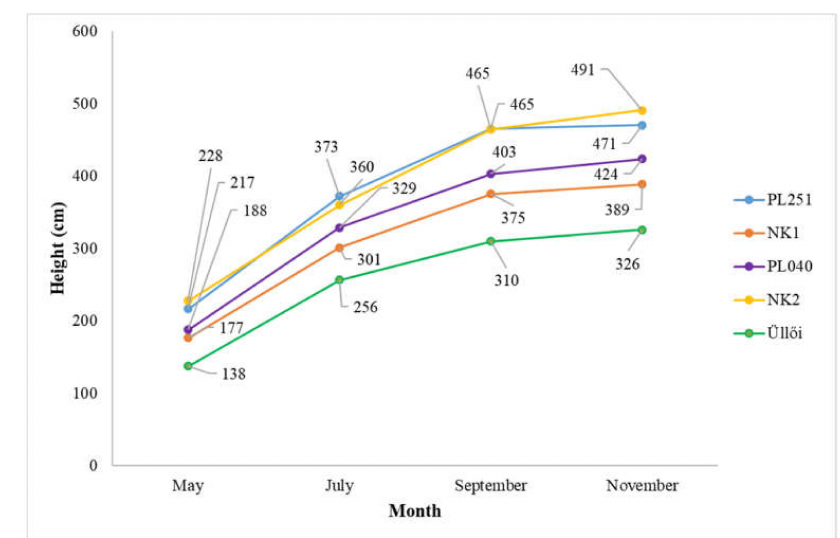
Figure 7. Height growth of the clones (May–November